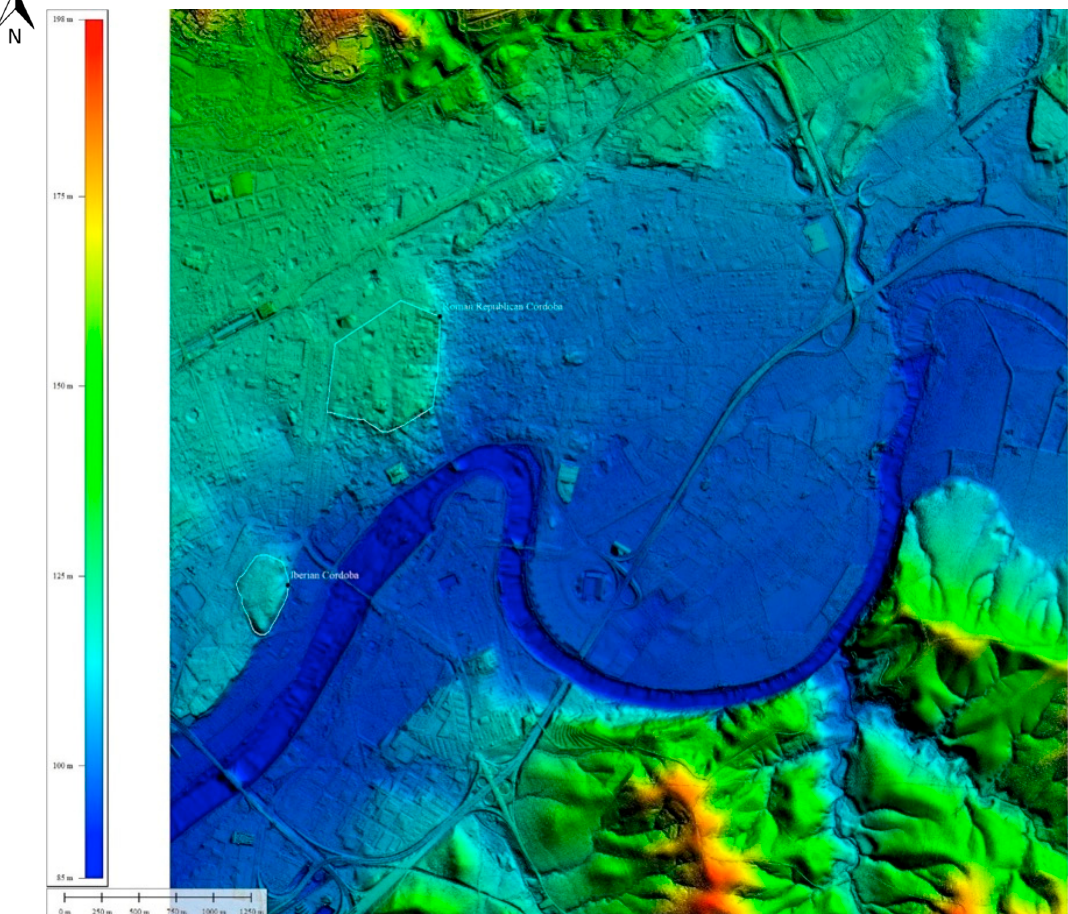
Figure 5. The settlement and enclosures of the pre-Roman and first Roman Cordoba are circled in white. DSM generated from LAS files. The ©PNOA-LiDAR 2016 CC-BY 4.0 ign.es files were processed with the Global Mapper 18.1 colour ramp shader hillshade by Antonio Monterroso-Checa. Coordinates in the central axis of the image: 37°52´43´´, 4°45´00”. 3.4. Geomorphological Reconstruction of a lost Hypothetical Meander of the Guadalquivir